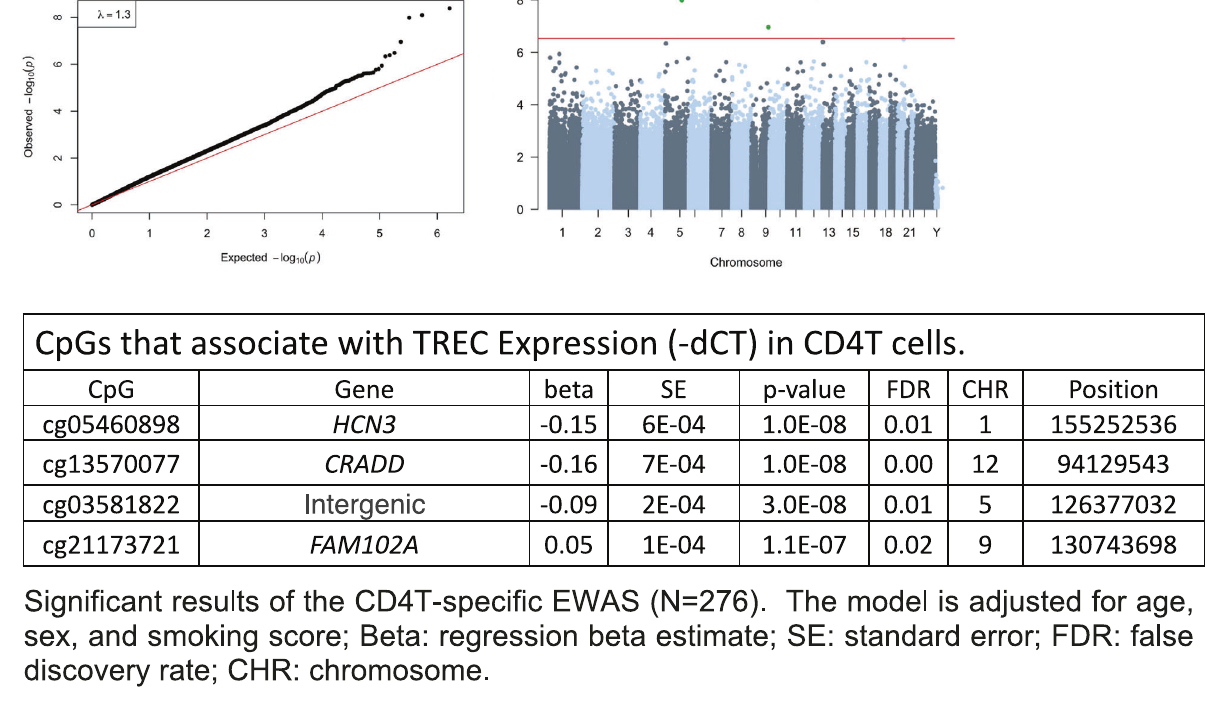
Fig. 5 Associations between TREC levels and cell-type speci fi c epigenome-wide association analysis (EWAS) in CD4T and CD8T cells in humans (men and women). A QQ plots of CD8T cell speci fi c EWAS for the comparison of 276 samples for which both TREC expression levels and methylation data were available. B Manhattan plot of CD8T cell speci fi c EWAS of TREC levels. The y-axis is the – log10 of the unadjusted p - value for the association with TREC expression level. The red line indicates genome-wide EWAS statistical signi fi cance at FDR < 0.05; for details, refer to Table 3. C QQ plots of CD4T cell speci fi c EWAS for the comparison of 276 samples for which both TREC expression level and methylation data were available. D Manhattan plot of CD4T cell speci fi c EWAS of TREC level. The y-axis is the – log10 of the unadjusted p-value for the association with TREC expression level. The red line indicates genome-wide EWAS statistical signi fi cance at FDR < 0.05; for details, refer to Table 4.